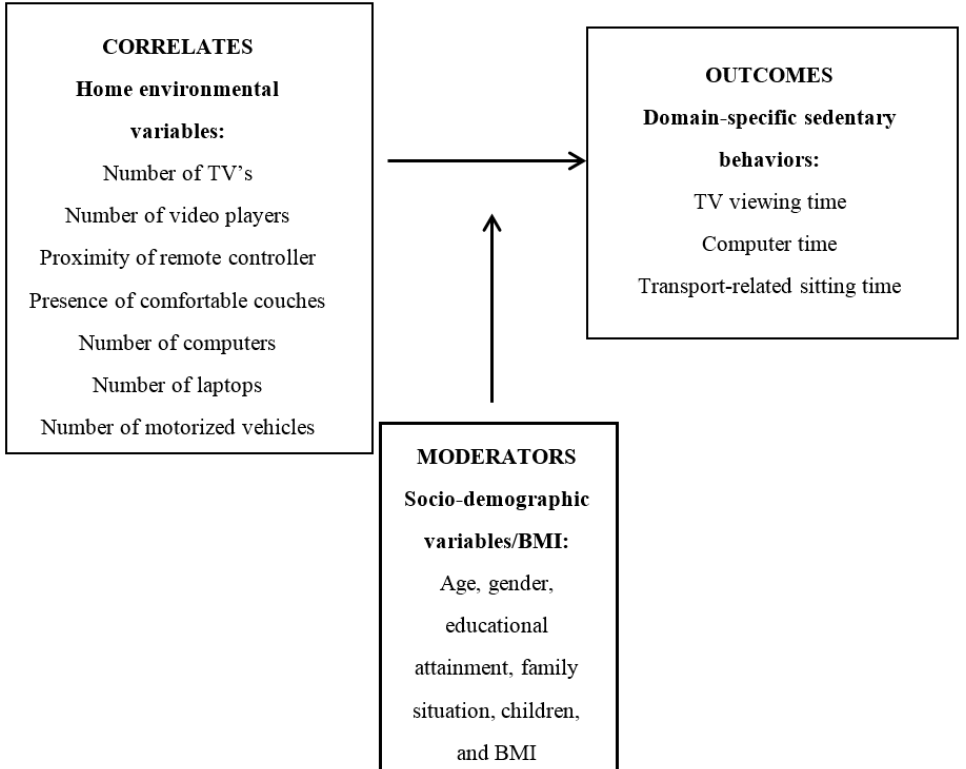
Figure 1. Moderation model: potential socio-demographic/BMI moderators in the relation between home environmental variables and domain-specific sedentary behaviors.